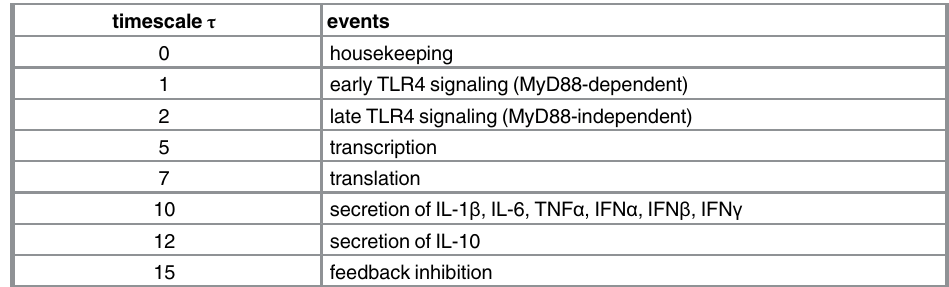
Table 1. Timescales of the Boolean